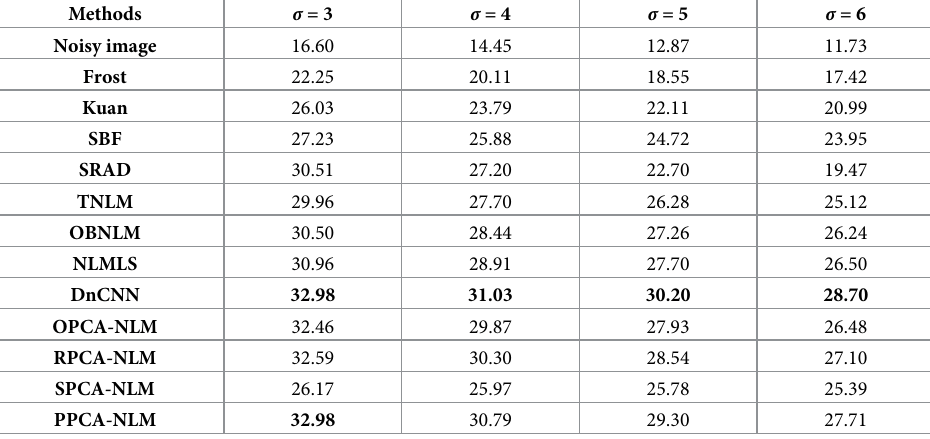
where W and H represent the width and height of the image, respectively. u is the noise-free image and ^ u is the denoised image. m ^ u and μ are the mean intensity of images ^ u and u , respec- u tively. d are the standard deviations of u is the covariance between images ^ u and u , s ^ u and σ u ^ u images ^ u and u , respectively. C and C are the small constants to stabilize SSIM. 1 2 Tables 1 and 2 list the PSNR and SSIM values for all evaluated methods operating on the synthetic image corrupted with different levels of speckle noise, where the best values are marked in bold. It can be seen that the DnCNN can produce the maximum PSNR at all noise Table 1. The PSNR (dB) values of various despeckling methods on the synthetic image.